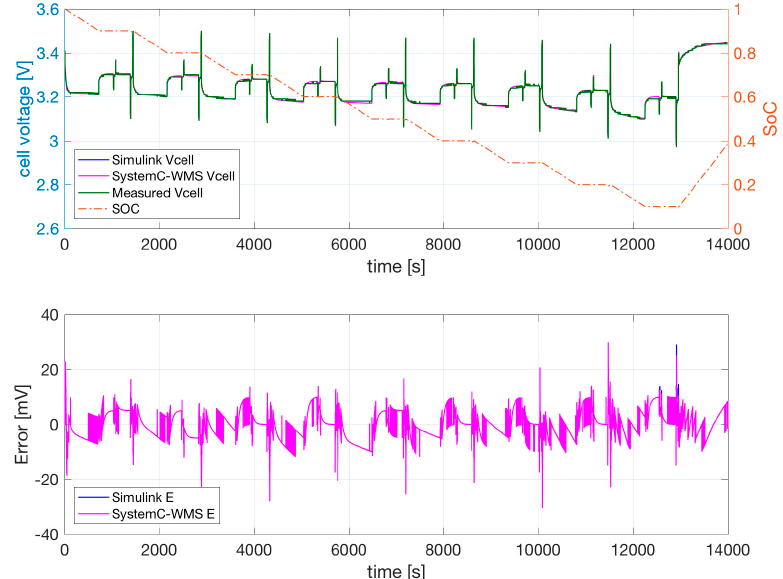
Figure 8. Measured voltage, SoC, SystemC-WMS, and Simulink simulations of the model shown in Figure 1b with parameters obtained with the extraction procedure and optimization at T = 25 °C. The lower part of this figure shows the error between SystemC-WMS and measurements and between Simulink and measurements.